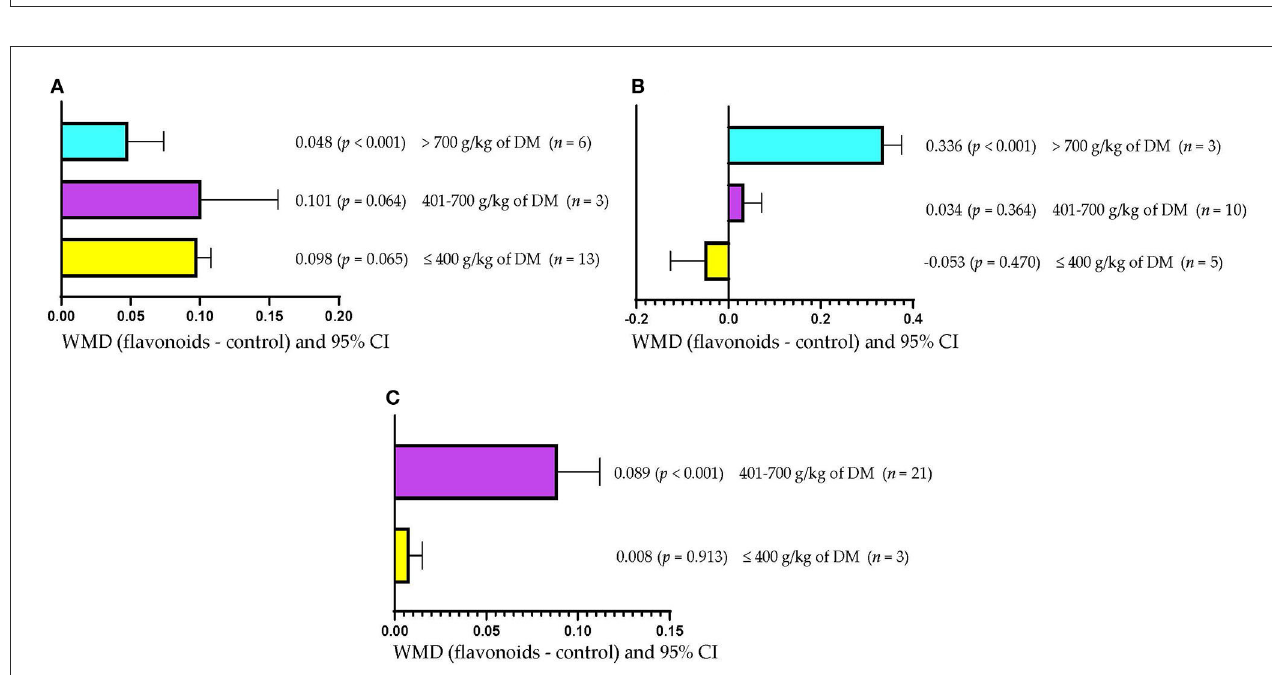
FIGURE3 Subgroup analysis [subgroup concentrate in diet (g/kg of DM)] of the effect of flavonoids on the diet of the cattle; WMDs, weighted mean differences = between flavonoid treatments and control. (A) Average daily gain (ADG), kg/d. (B) Ruminal pH. (C) Milk protein, g/100g.